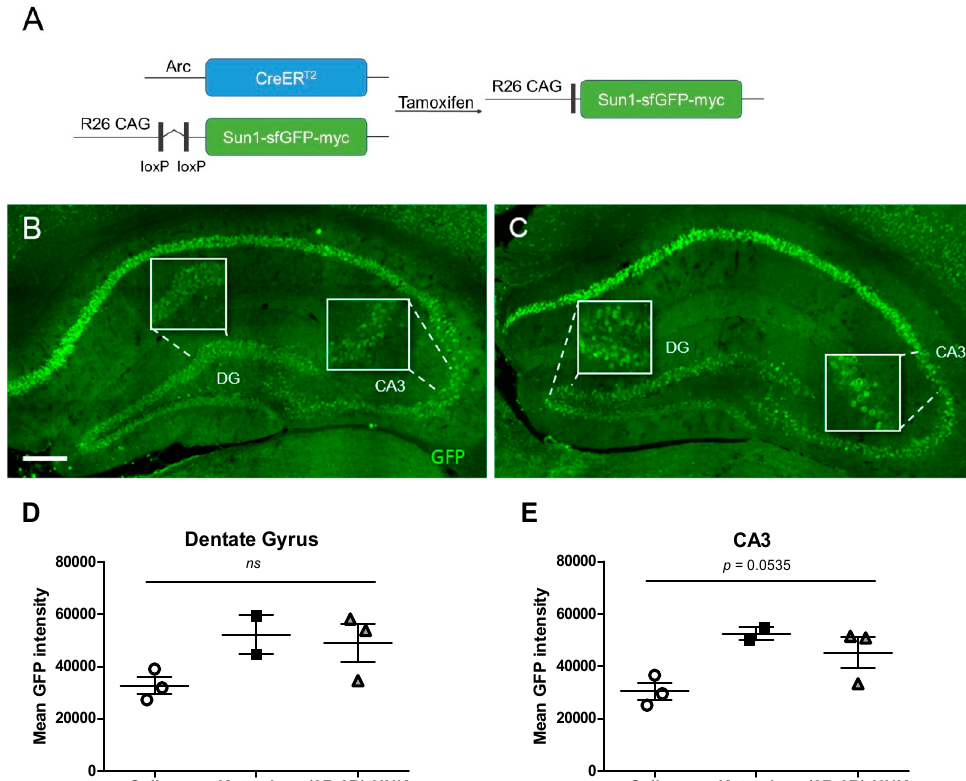
Figure 3 . Green fluorescent protein (GFP)-labelled activated nuclei in the hippocampal dentate gyrus (DG) and Cornu Ammonis region 3 (CA3) after a single injection with ketamine or (2R,6R)-HNK in female mice. ( A ) Genetic design. Administration of tamoxifen (TM) to Arc-CreER T2 × CAG-Sun1 / sfGFP mice induced a Cre-mediated recombination in activated CreER T2 -expressing neurons, thus resulting in permanent GFP label on the nuclear membrane in the activated neurons. ( B , C ) Immunohistochemical GFP staining of coronal sections showing the DG and CA3 region of the hippocampus of female Arc-CreER T2 × CAG-Sun1 / sfGFP mice injected with ketamine ( B ) or (2R,6R)-HNK ( C ). Magnification 20 × , scale bar represents 200 µ m. Insert pictures represented zoomed-in details. Ketamine and (2R,6R)-HNK did not significantly alter GFP-labelled Arc expression in DG ( D ) or CA3 ( E ). A trend towards significance is observed in CA3 (DG: one-way ANOVA, F (2, 5) = 2.965, p = 0.1416; CA3: one-way ANOVA, F (2, 5) = 5.566, p = 0.0535). Arc expression is reflected in mean GFP intensity, which is displayed in mean gray values. Error bars represent ± SEM. N = 2–3 mice / group, 3 sections per animal, ns = not